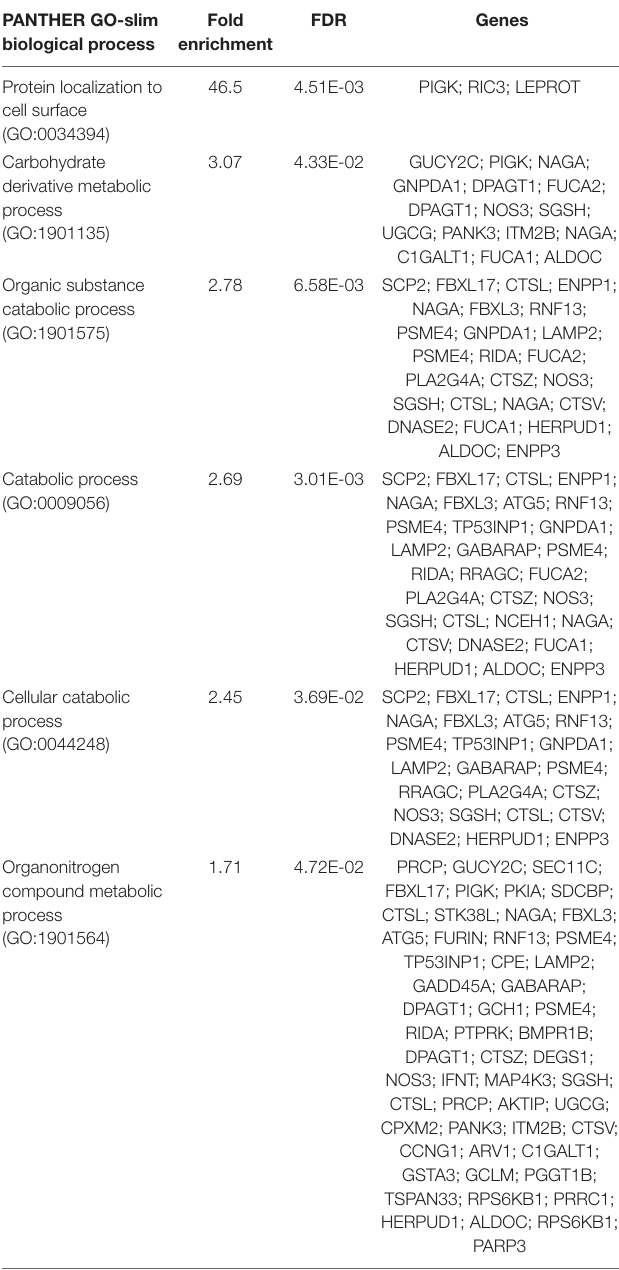
TABLE 6 | Enrichment of genes overexpressed in ICM under “SC” versus “SF” IVP conditions. PANTHER GO-slim Fold FDR biological process enrichment